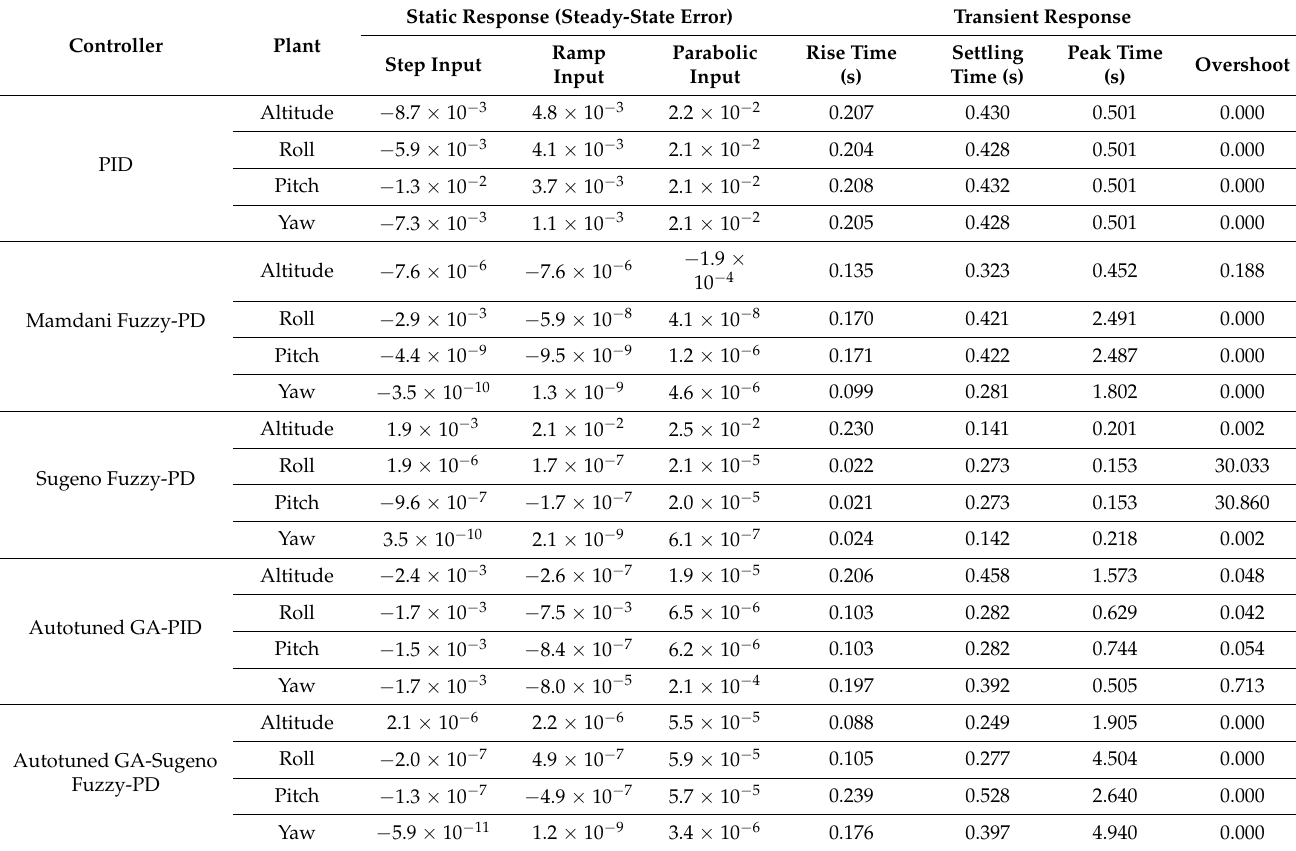
Table 3. Comparison of the steady-state and transient response of the